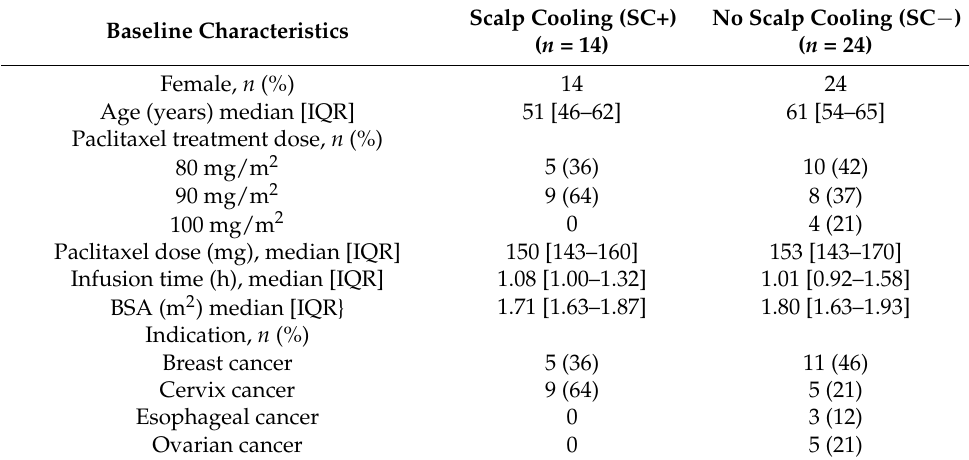
Table 1. Baseline